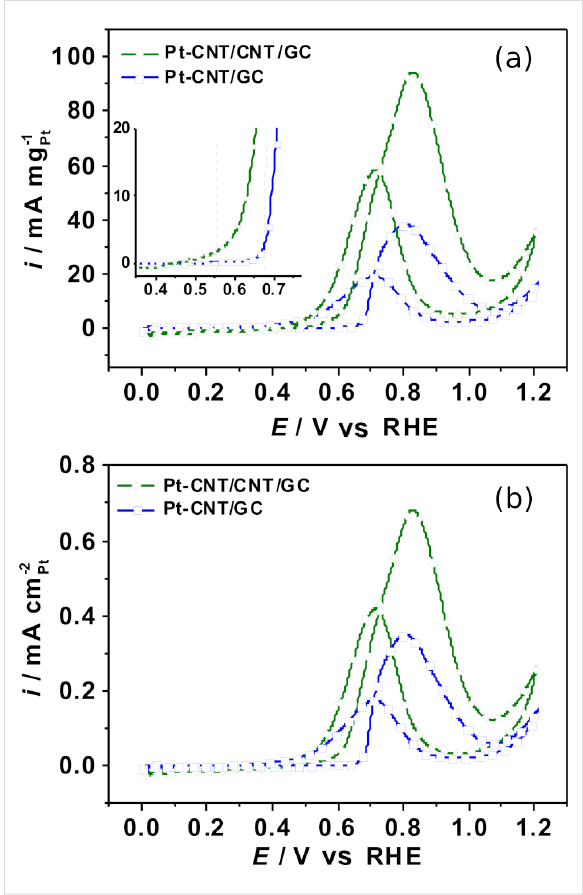
Figure 10: Cyclic voltammograms of Pt-CNT/GC and Pt-CNT/CNT/GC in N 2 -saturated 1 M CH 3 OH and 0.5 M H 2 SO 4 electrolyte solution re- corded at a scan rate of 5 mV s − 1 normalized to a) Pt mass and b) Pt-ECSA evaluated by CO ad stripping. The vertical dashed lines are intended as a guide for the